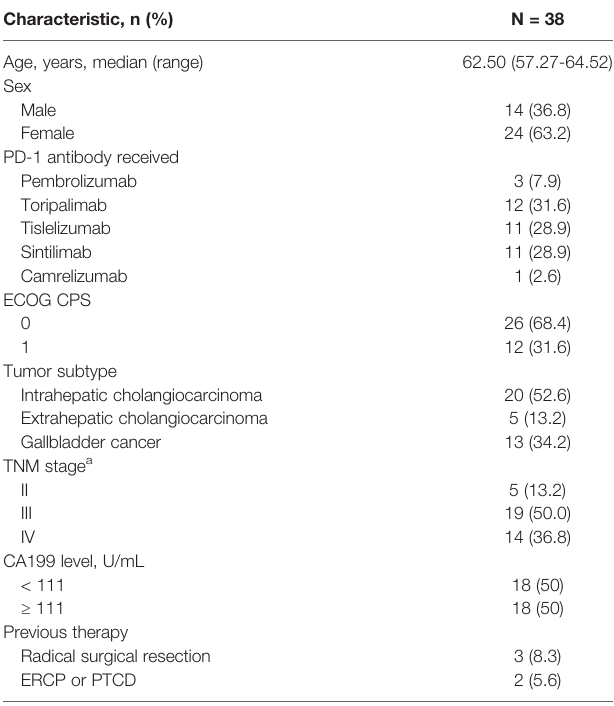
a Clinical staging was based on the8 th edition ofthe American Joint Committee on Cancer (AJCC) Staging Manual. CA199, carbohydrate antigen 199; CPS, combined positive score; ECOG, Easter Co- operative Oncology Group; ERCP, endoscopic retrograde cholangiopancreatography; PTCD, percutaneous transhepatic cholangiography and